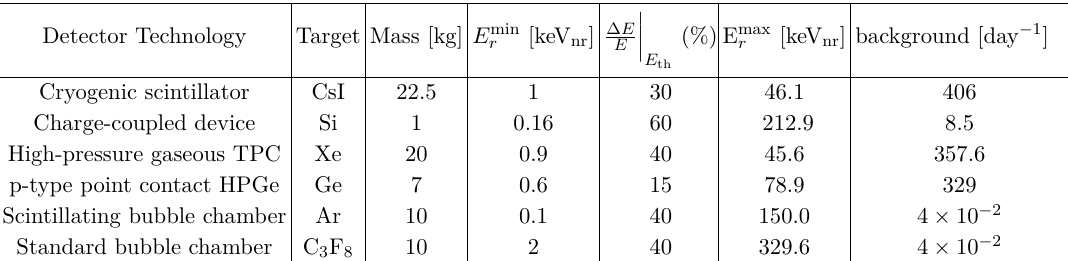
Table 2. Summary of properties for the detectors possibly employed at the ESS: target, mass, recoil energy threshold, width for the smearing and maximum recoil energy, steady-state background. The steady-state background include the 4 × 10 − 2 reduction by the ESS duty